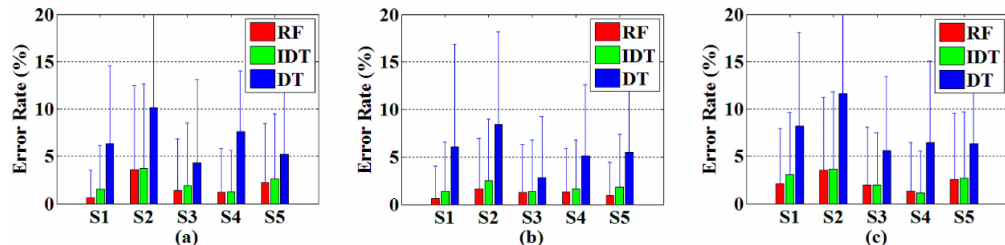
Figure 9. Subword recognition results achieved by the proposed RF method in comparison to the IDT and DT for five different signers (S1–S5) using three-fold cross validation. ( a ) the first repetition dataset for testing; ( b ) the second repetition dataset for testing; ( c ) the third repetition dataset for testing.